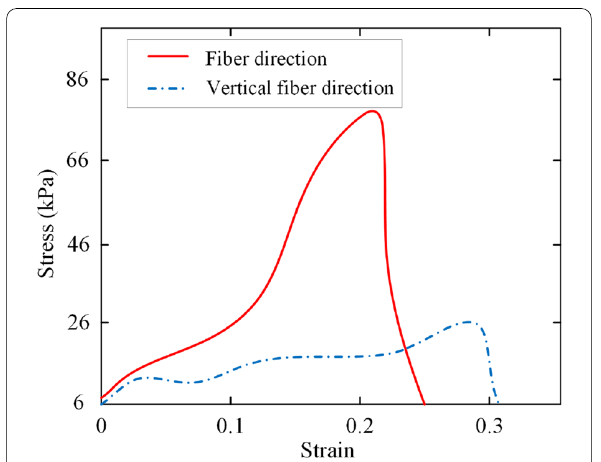
Figure 2 Stress-strain curve in different tensile directions